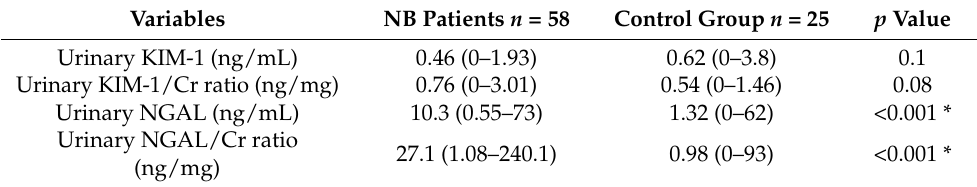
Table 2. Biochemical parameters in patients with NB after MMC and control